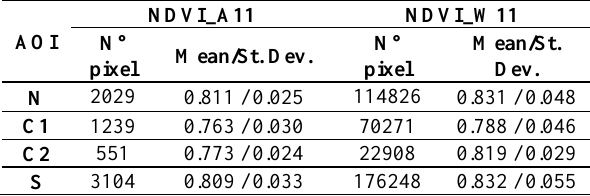
Table 1. Basic statistics of NDVI values